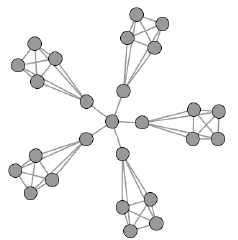
Figure 2. An extremal example illustrating the efficacy of node-based resilience measures, which attack the central node, resulting in five